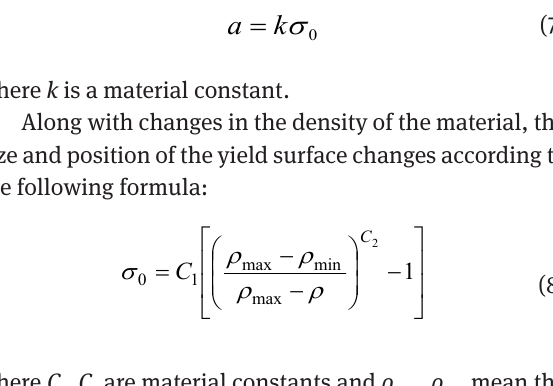
Figure 6: a) Elliptical failure surfaces and critical state line (csl) on plane σ minor axes size ( a , b ) as the function of density